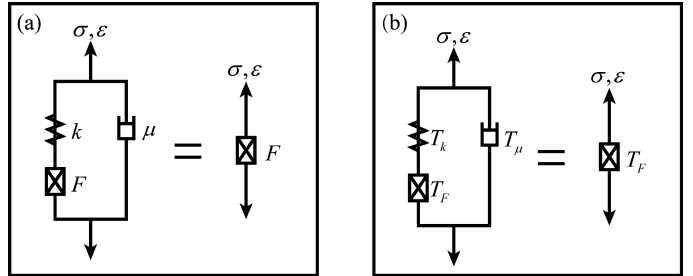
Figure 4. Equivalence of structural elements and fractal operators of cell elements of functional fractal trees. ( a ) Equivalence of component fractal tree with fractal cell and fractal element; ( b ) The invariance of the operator fractal